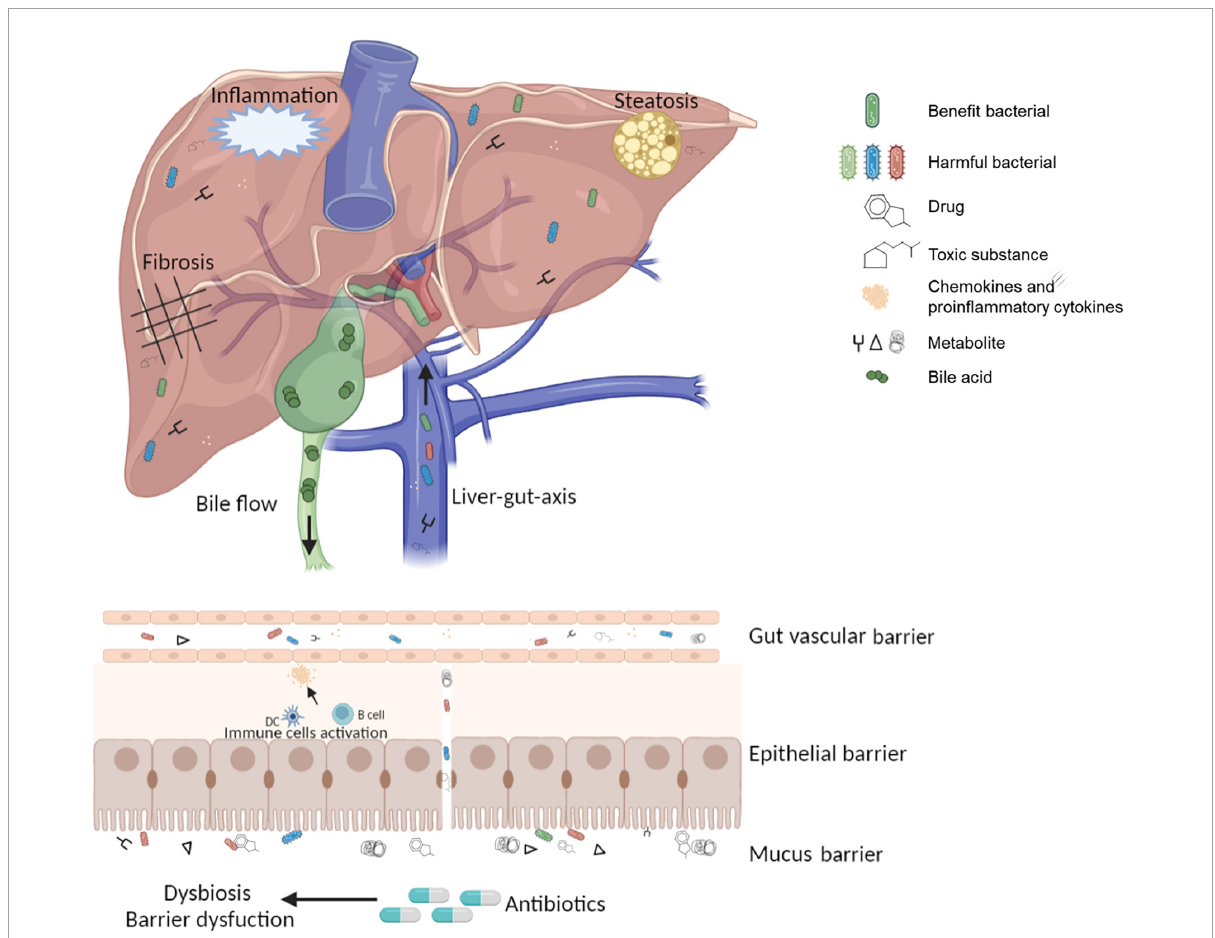
FIGURE1 The pathological state of the gut-liver-immune axis and gut microbiota under antibiotic